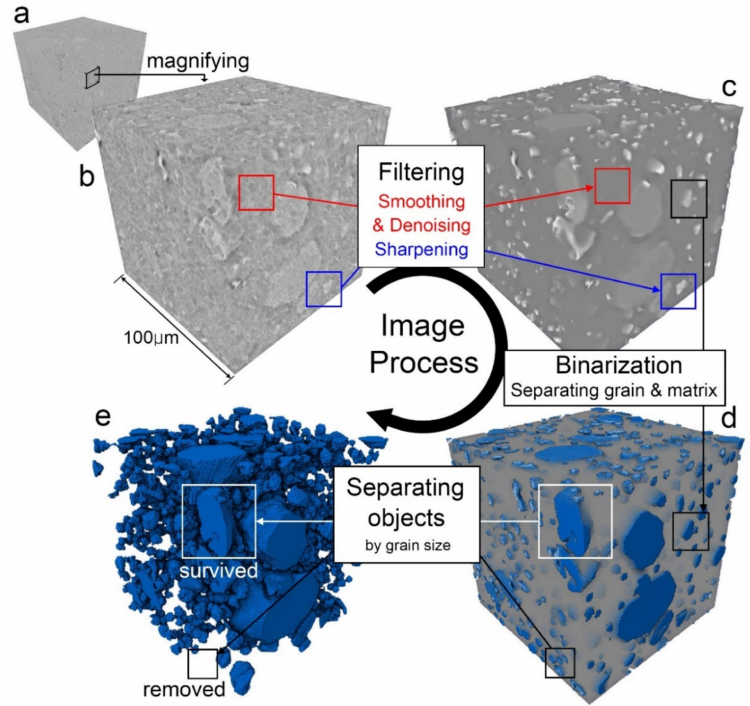
Figure 4. Diagram of image filtering process, binarization, and sorting. ( a ) 3D µ -CT image of the whole measured BK-1 sample. ( b ) Magnified (5 × ) CT image of BK-1 sample without any image